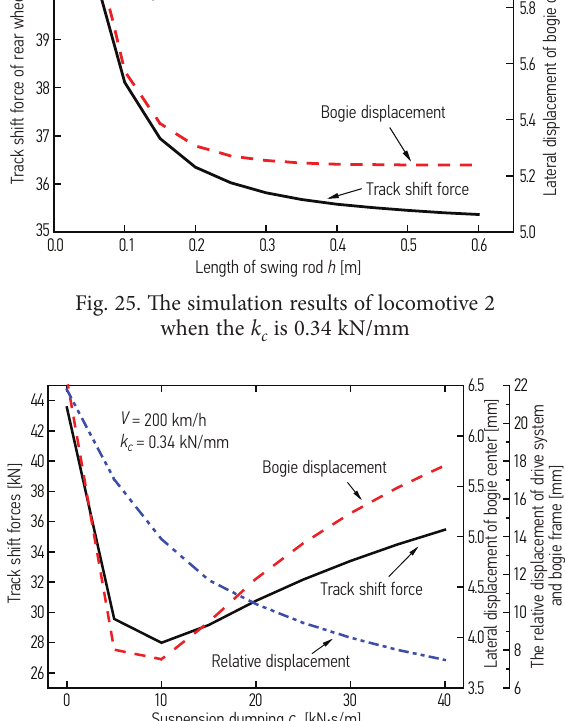
Fig. 26. The simulation results of locomotive 2 with different c y